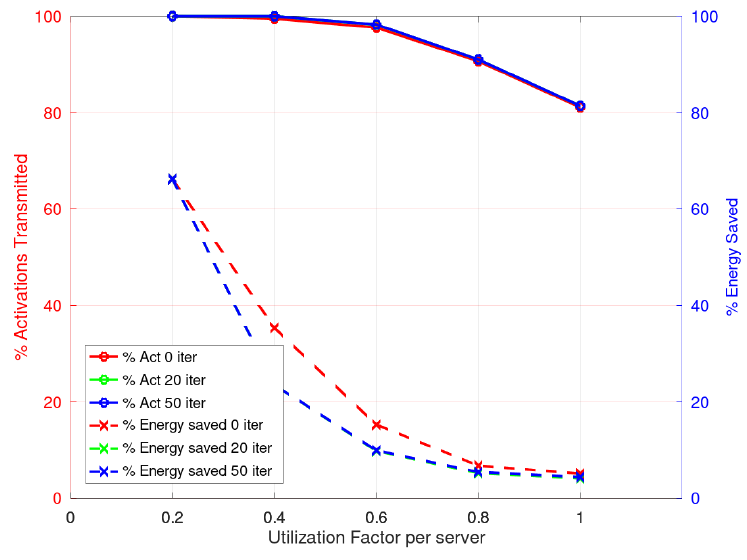
Figure 9. Multistart ad-hoc heuristic, activation